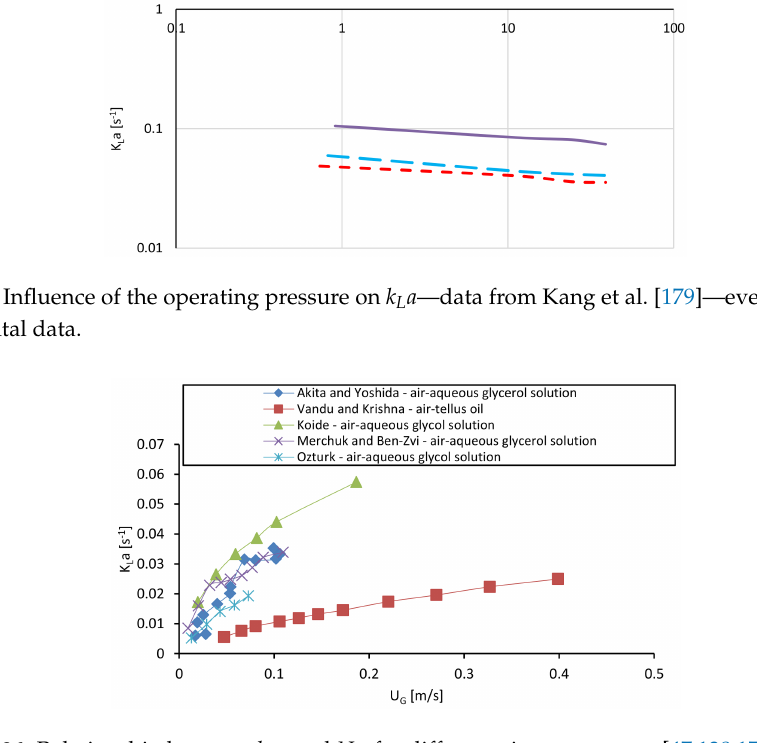
Figure 36. Relationship between k L a and U G for different viscous systems